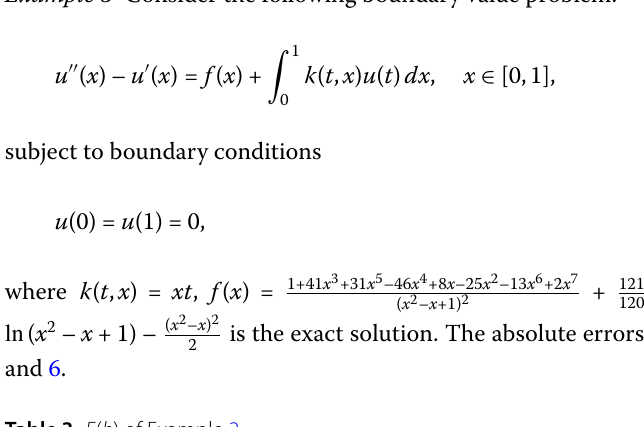
Table 3 E ( h ) of Example 2